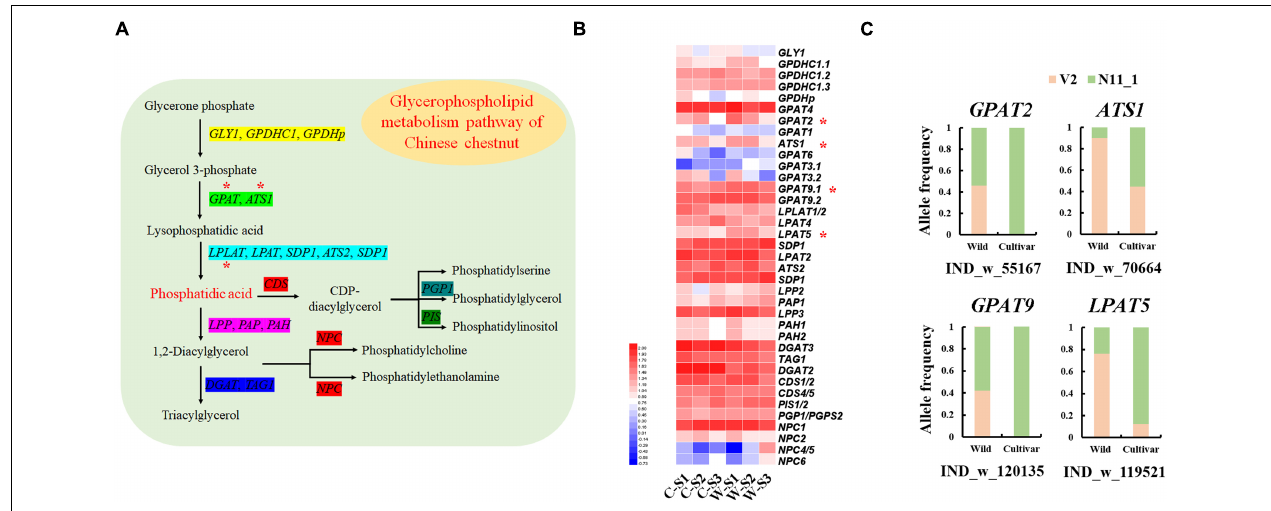
FIGURE 5 | Glycerophospholipid metabolism genes associated with the germination of Chinese chestnut seeds. (A) Model of the glycerophospholipid metabolism pathway in Chinese chestnut; * indicates significant key genes. (B) The glycerophospholipid metabolism gene expression profiles of Chinese chestnut, where * indicates a significant difference at P < 0.05. (C) Allele frequencies of selected SVs in wild and cultivated Chinese chestnut.